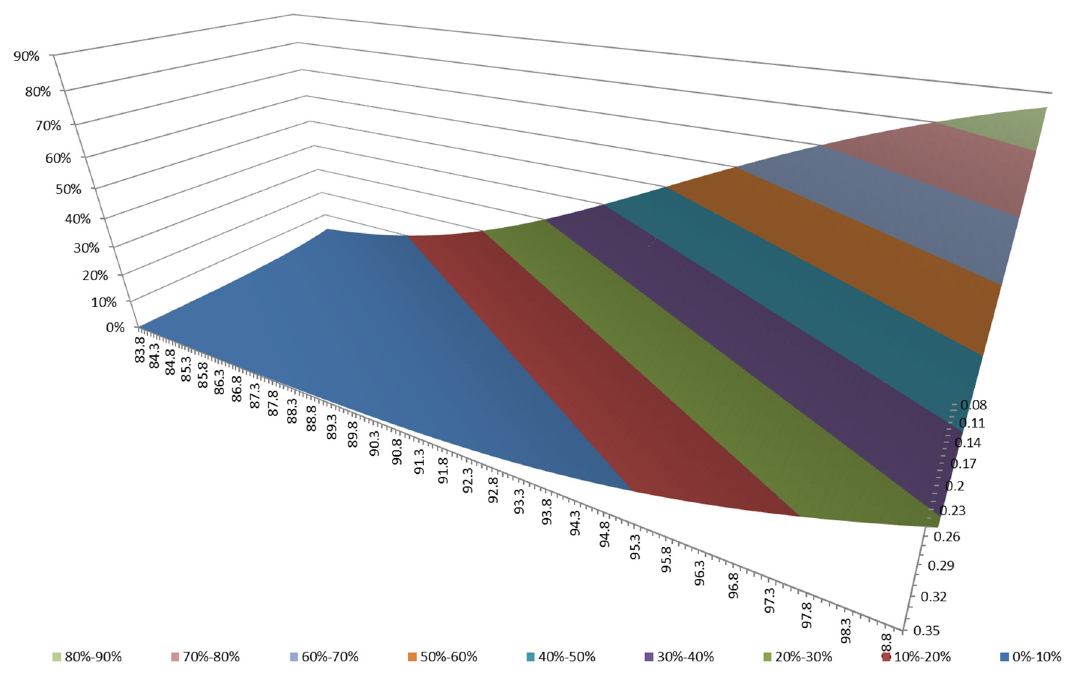
Figure 5. Probability of GDP being in boom state ( d sample period runs from 1990q1 to 2013q4.